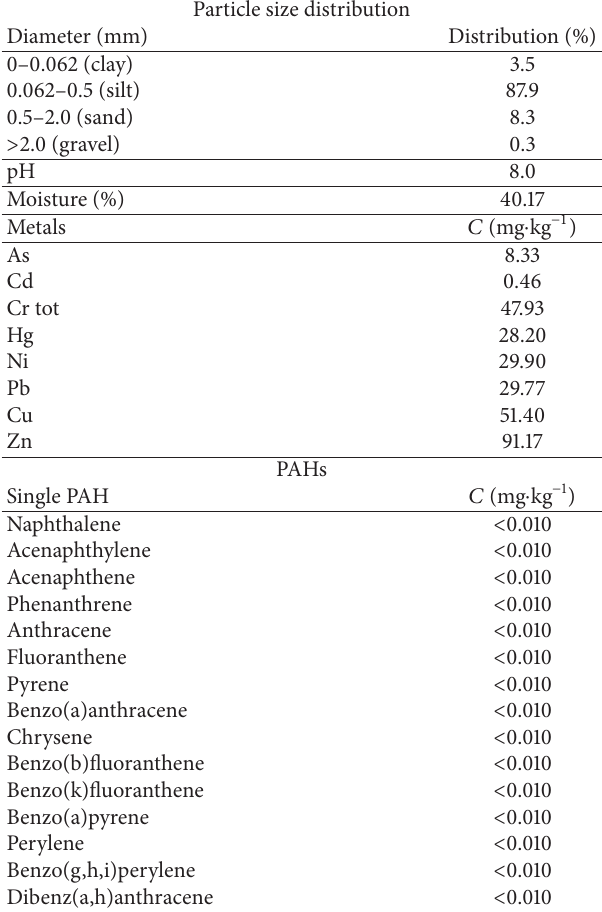
Table 4: Physicochemical properties of dredged